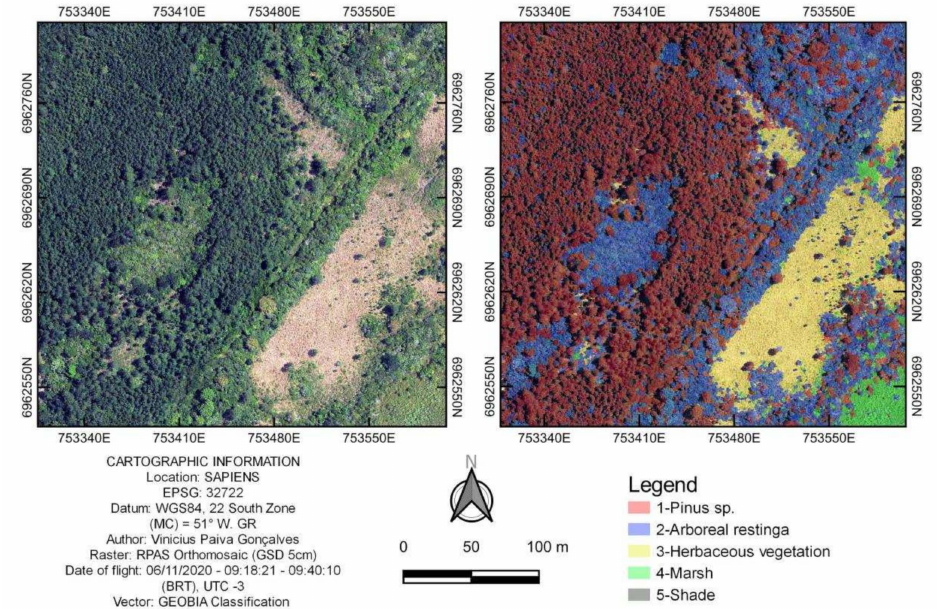
Figure 6. Comparison of the SAPIENS area orthomosaic and classified images (higher kappa), overlaid with 65% transparency. CRS: EPSG 32722. Horizontal datum WGS84, UTM projection system, 22 South Zone. MC 51 ◦ W. GR. Raster: RPAS Orthomosaic (GSD 5 cm). Fight date: 06/11/2020, 09:18:21–09:40:10 Brasilia Time (BRT),